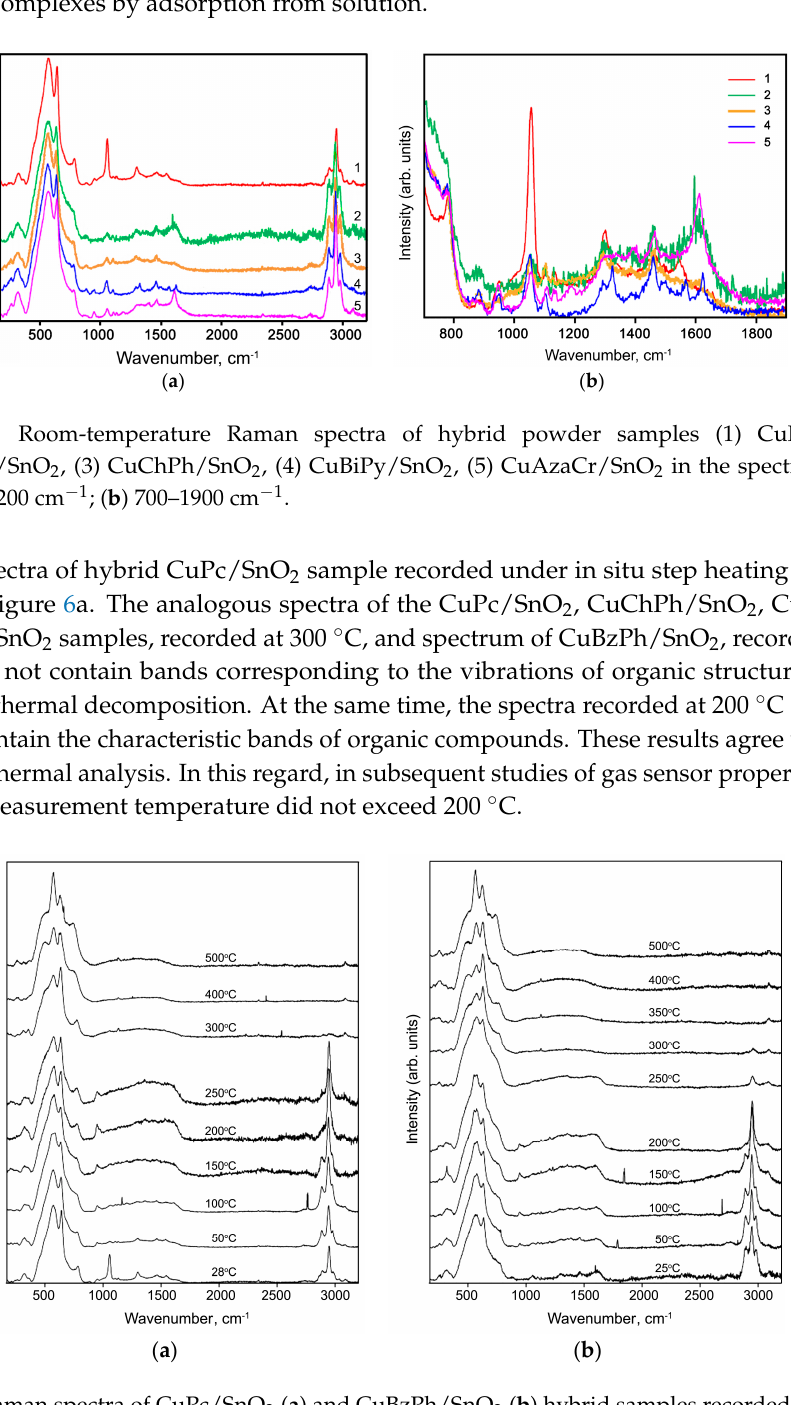
Figure 6. Raman spectra of CuPc/SnO 2 ( a ) and CuBzPh/SnO 2 ( b ) hybrid samples recorded under in situ step heating up to 500 °C. situ step heating up to 500 ◦